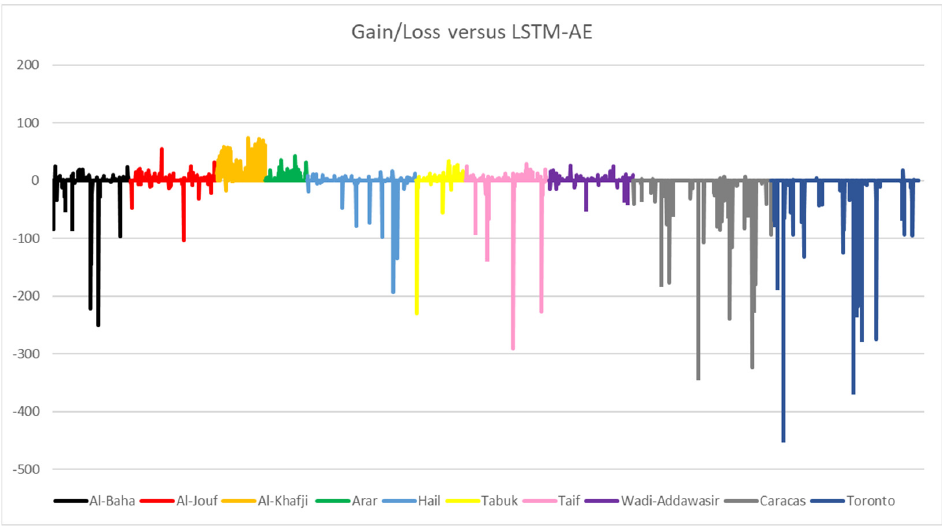
Figure 39. Gain or loss of SENERGY versus LSTM-AE.